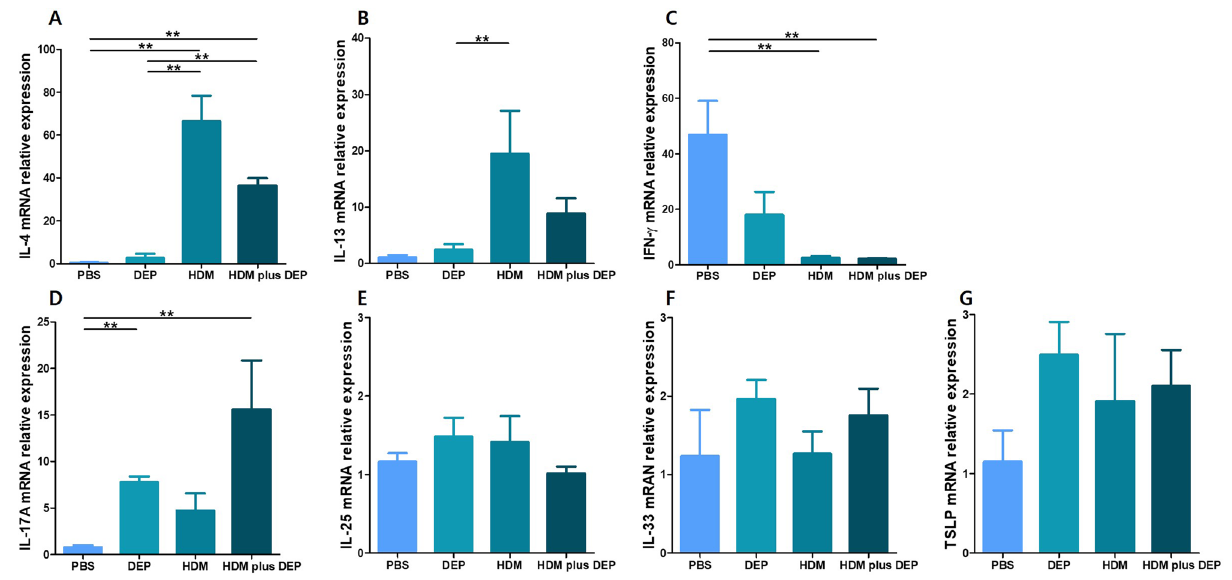
Figure 5. Real-time PCR analysis of cytokines expression in the nasal mucosa. Expression of ( A ) IL-4, ( B ) IL-13, ( C ) IFN-γ, and ( D ) IL-17A, ( E ) IL-25, ( F ) IL-33, ( G ) TSLP in the nasal mucosa detected by real-time PCR. The transcriptional levels of IL-17A were increased in mice co-exposed to HDM and DEP. Data are expressed as mean ± standard error mean. ** p <